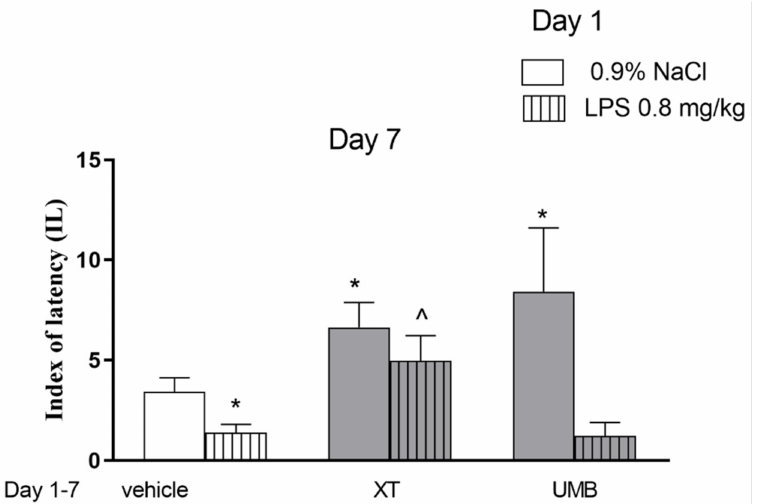
Figure 2. Effects of subchronic administration of xanthotoxin (XT, 15 mg/kg) and umbelliferone (UMB, 15 mg/kg, i.p.) on LPS (0.8 mg/kg)-induced impairment of memory acquisition trial using the PA test in mice. Mice were injected with XT and UMB 60 min after LPS administration